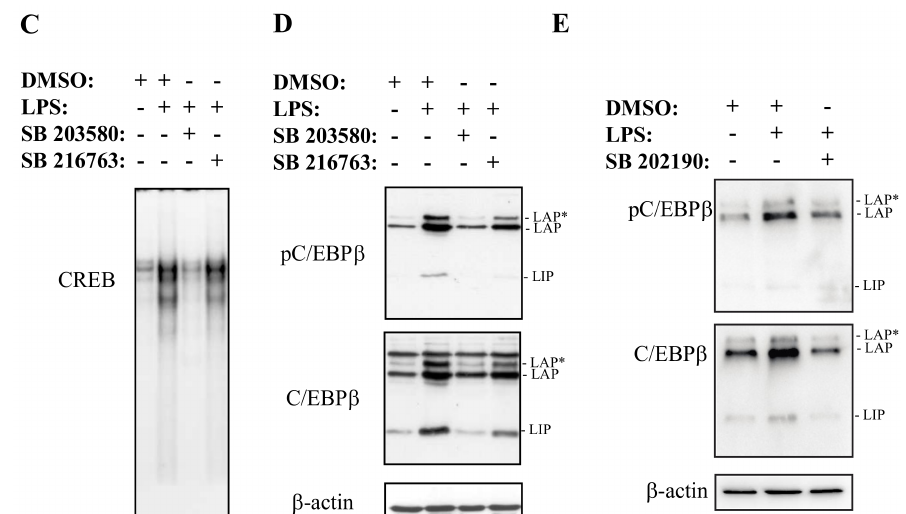
Figure 2. Role of p38 MAPK/CREB and GSK3b/CREB axis in the activation and DNA binding activity of C/EBP β in GM/DCs. Bone marrow-derived GM/DCs were preincubated with inhibitors of p38 MAPK (SB203580, 10 µ M), p38 MAPK (SB202190, 1 µ M), GSK3 (SB 216763, 10 µ M), or vehicle (DMSO) for 1 h before stimulation with LPS (1 µ g/mL for 8 h). ( A ) C/EBP β DNA binding activity in nuclear extracts were analyzed by EMSA. ( B ) Western blot analysis of the levels of phosphorylated (Ser129, Ser133) and total CREB in whole cell lysates at the indicated times (hours) after LPS stimulation (1 µ g/mL). ( C ) CREB DNA binding activity in nuclear extracts were analyzed by EMSA. ( D , E ) Western blot analysis of the levels of phosphorylated (Thr188) and total C/EBP β in whole cell lysates after 8 h of LPS stimulation (1 µ g/mL). Data are representative of two independent